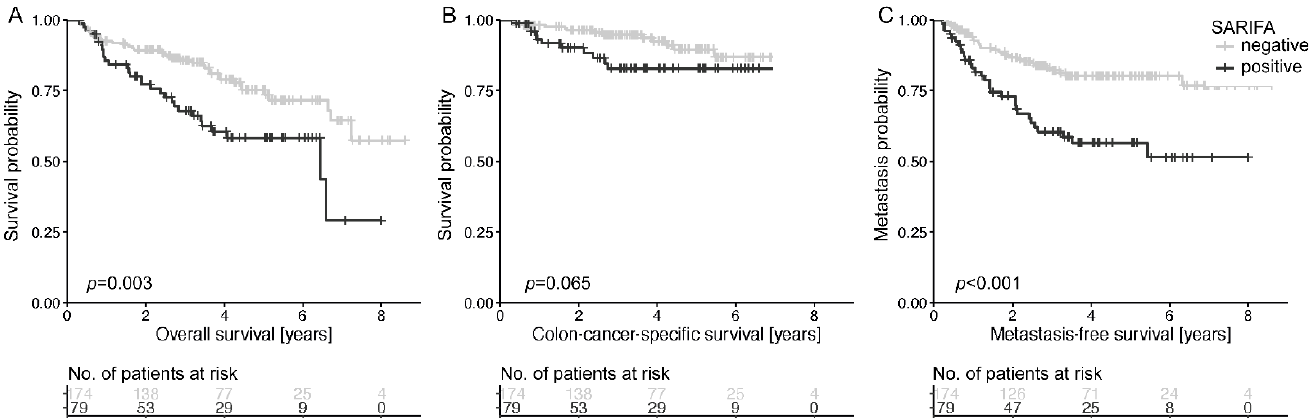
Figure 3. Discrimination of patient overall survival ( A ), colon-cancer-specific survival ( B ), and metastasis-free survival ( C ) based on SARIFA status in group B. The Kaplan–Meier curves of patients with SARIFA-positive and SARIFA-negative tumors are shown. p -value of log-rank test.